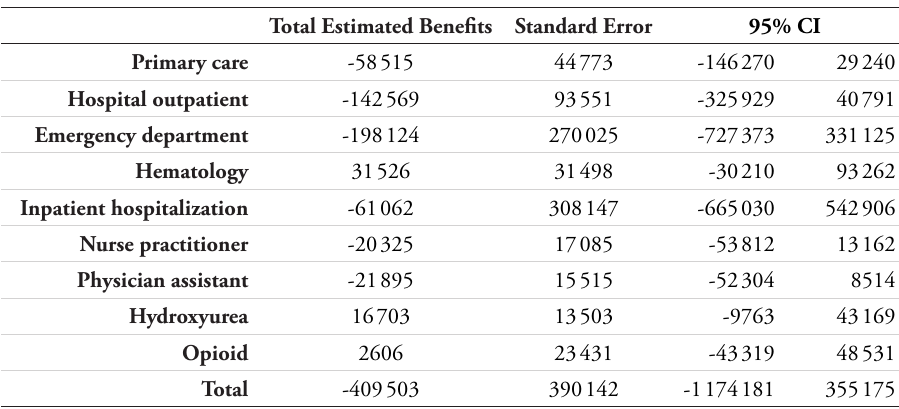
Table 4. Total Estimated Expenditure Benefit after